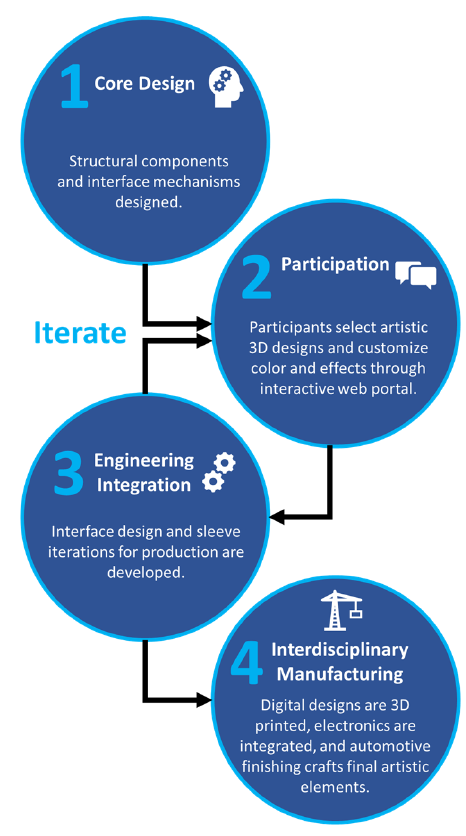
Figure 4. Overview of design process and methodology from design generation, user participation, and interdisciplinary